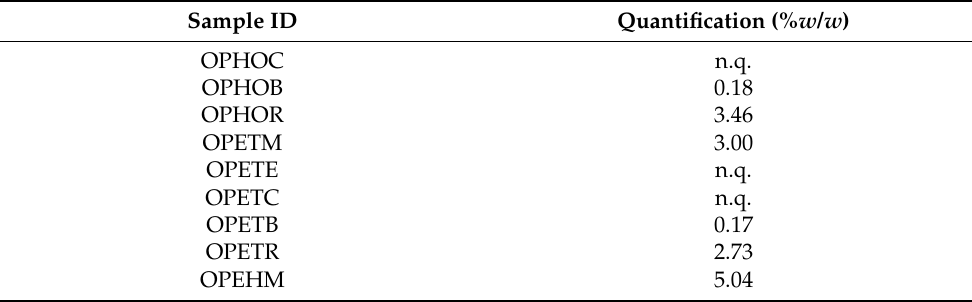
Table 4. Quantitative analysis of the betanin present in the analyzed OFP